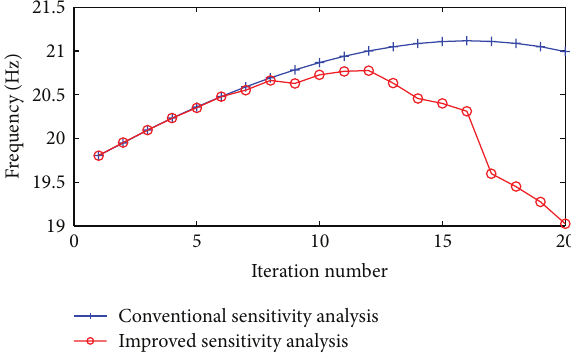
Figure 8: Iteration histories of objective function value.